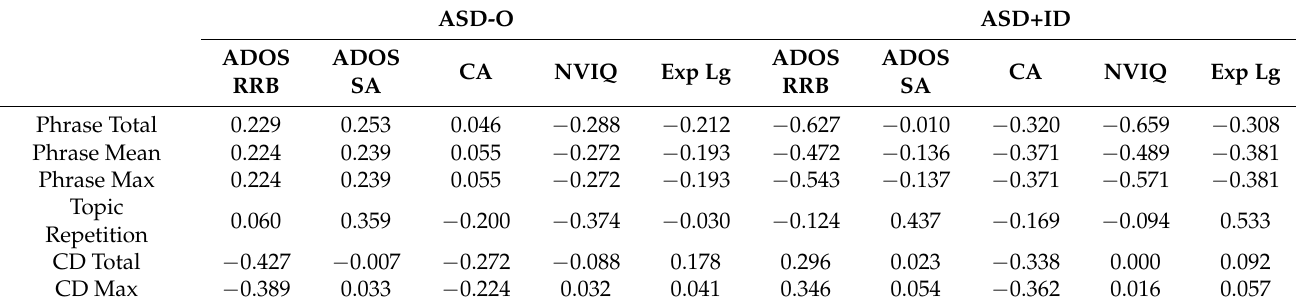
Table 6. Correlations between repetitive language measures and ADOS-RRB, ADOS-SA, CA, and NVIQ after separating groups into ASD-O and ASD+ID and controlling for number of